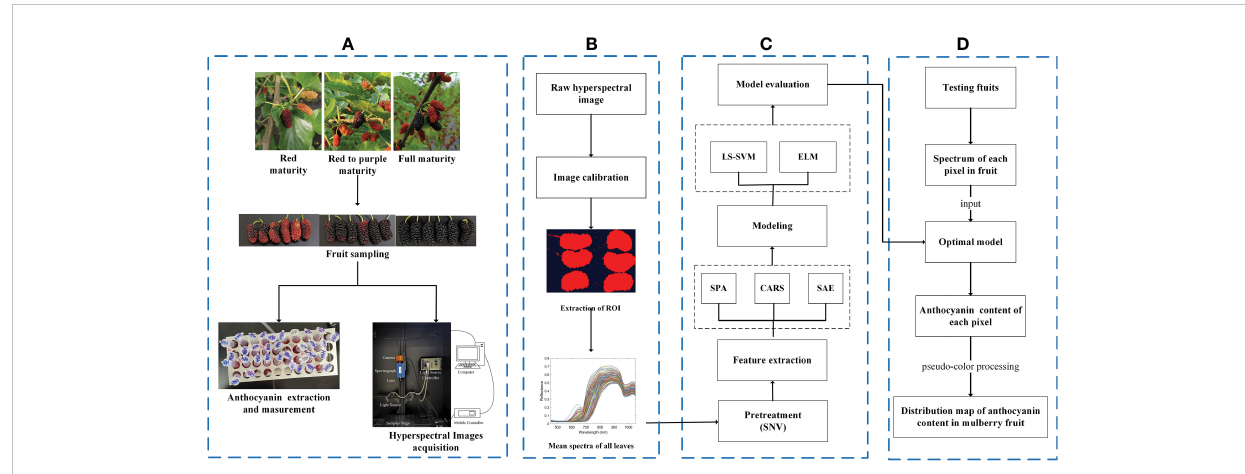
FIGURE 3 Overall fl ow chart. (A) Acquisition of data; (B) hyperspectral image processing; (C) analysis of spectral data; (D) visualization of anthocyanin